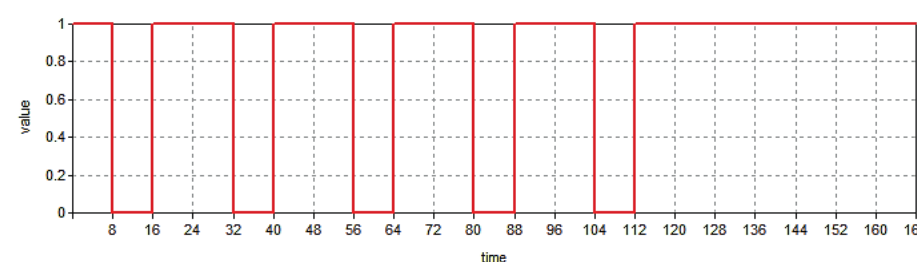
Fig. 3. Building occupancy